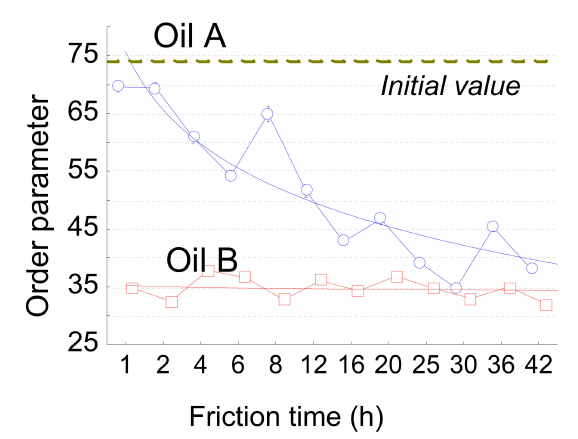
Figure 15. Order roughness parameters evolution versus friction time for the two oil A and oil